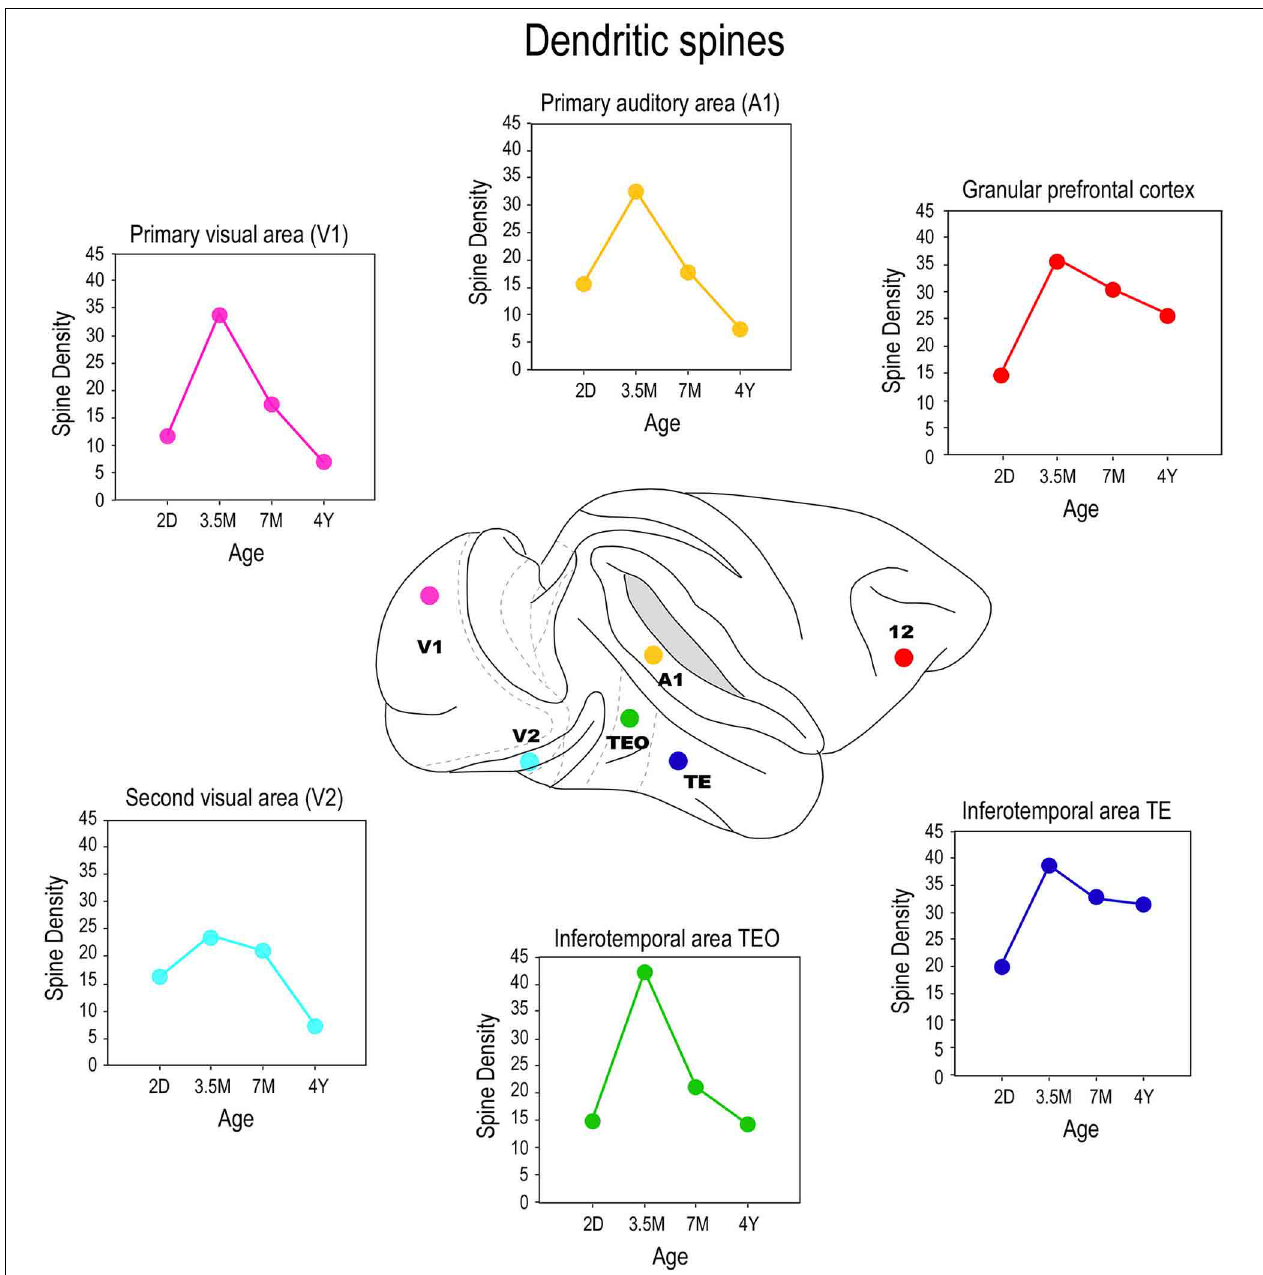
FIGURE 7 | Spinogenesis. Plots of the peak spine density (defined as the average of the maximum spine density observed in all 10 μ m segments of dendrite from the soma to the distal tips of the dendrites of all cells quantified for any given age) of layer III pyramidal cells sampled in the primary visual area (V1), the second visual area (V2), the primary auditory area (A1), the posterior and anterior portion of the inferior temporal cortex (TEO and TE, respectively) and prefrontal cortex (Brodmann’s area 12) at postnatal day two (2D), three and a half months of age (3.5M), seven months of age (7M) and 12, on the other hand, have relatively stable branching